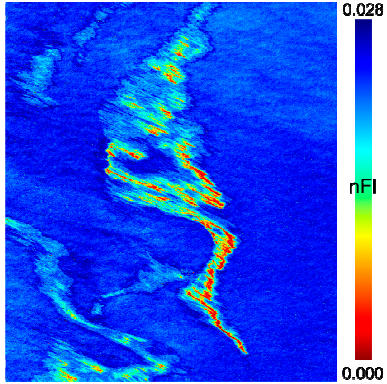
Figure 11. Score maps resulting from spectral index nFI.